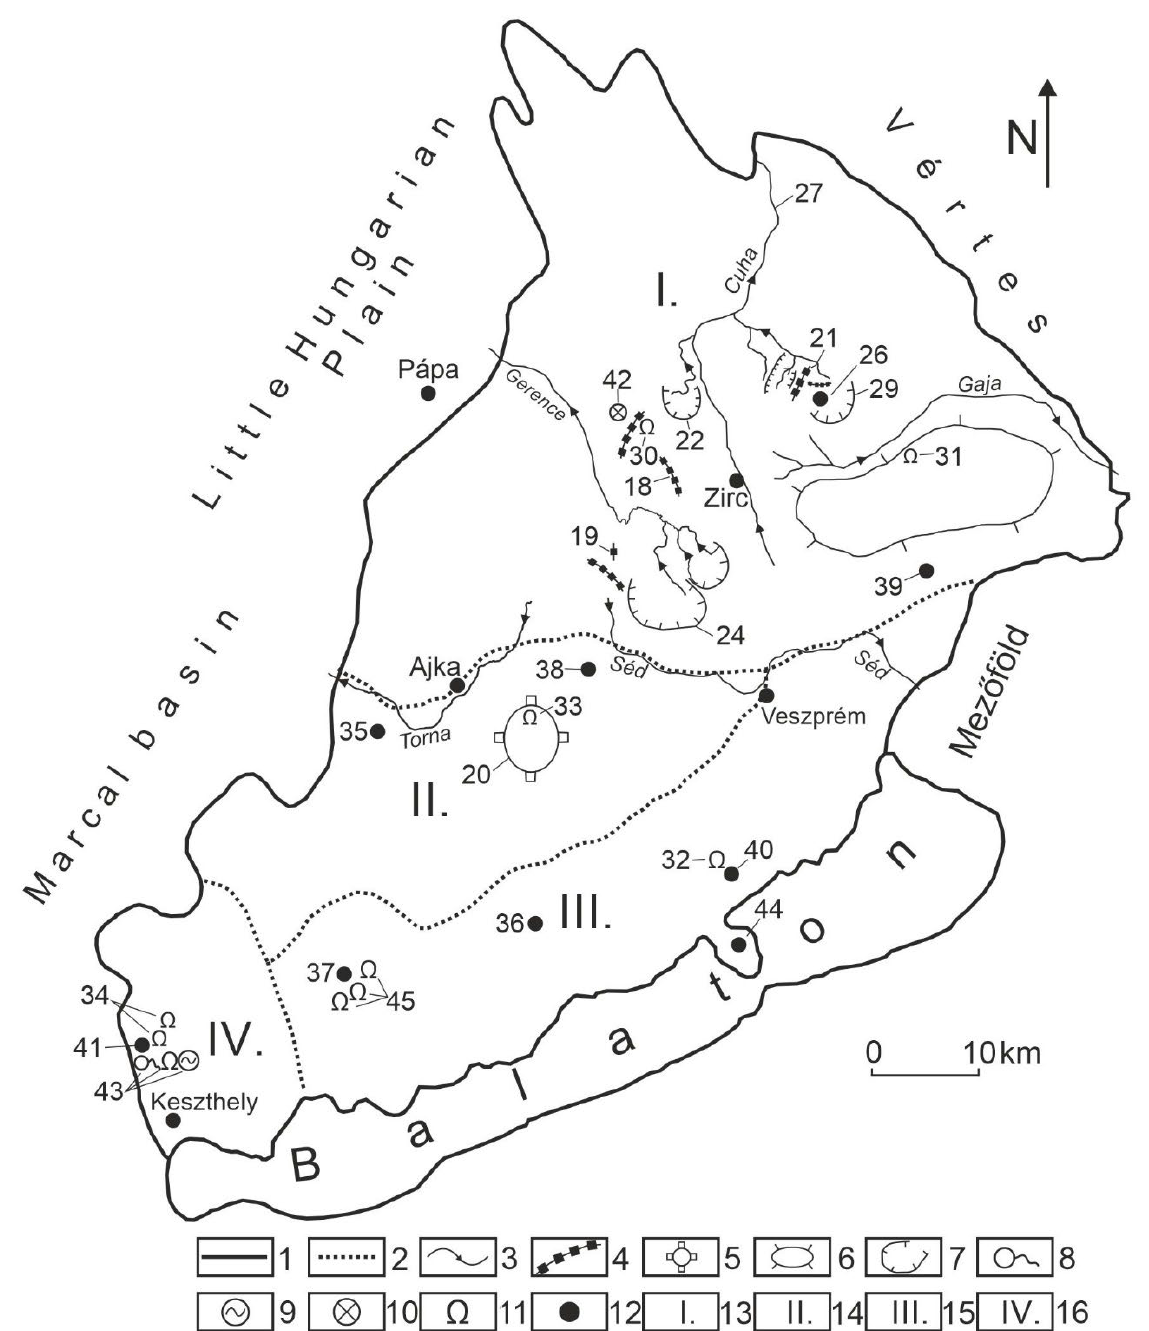
Figure 1. Parts of the Bakony Region. Legend: 1. boundary of mountains, 2. boundary of micro- region group, 3. stream, 4. horst, 5. basaltic horst, 6. plateau, 7. basin, 8. karst spring, 9. karst lake, 10. doline group, 11. cave, 12. settlement, 13. Northern Bakony, 14. Southern Bakony, 15. Balaton Uplands, 16. Keszthely Mountains, 17. Kőris Mounta in, 18. Som Mountain, 19. Mester-Hajag, 20. Kab Mountain, 21. Sűrű mountain group, 22. Porva basin, 23. Lókút basin, 24. Hárskút basin, 25. Tapolca basin, 26. Dudar basin, 27. Cuha valley, 28. Gerence valley, 29. Ördög valley, 30. Ördög-lik of Kőris Mounta in, 31. Alba-Regia cave, 32. Lóczy cave, 33. Öreg-köves inflow cave, 34. Cserszegtomaj caves, 35. Devecser, 36. Szentbékálla, 37. Tapolca, 38. Márkó, 39. Hajmáskér, 40. Balatonfüred, 41. Hévíz, 42. Eleven-Förtés doline group, 43. Lake Hévíz and its spring cave, 44. Tihany Peninsula, 45. Tapolca cave system.